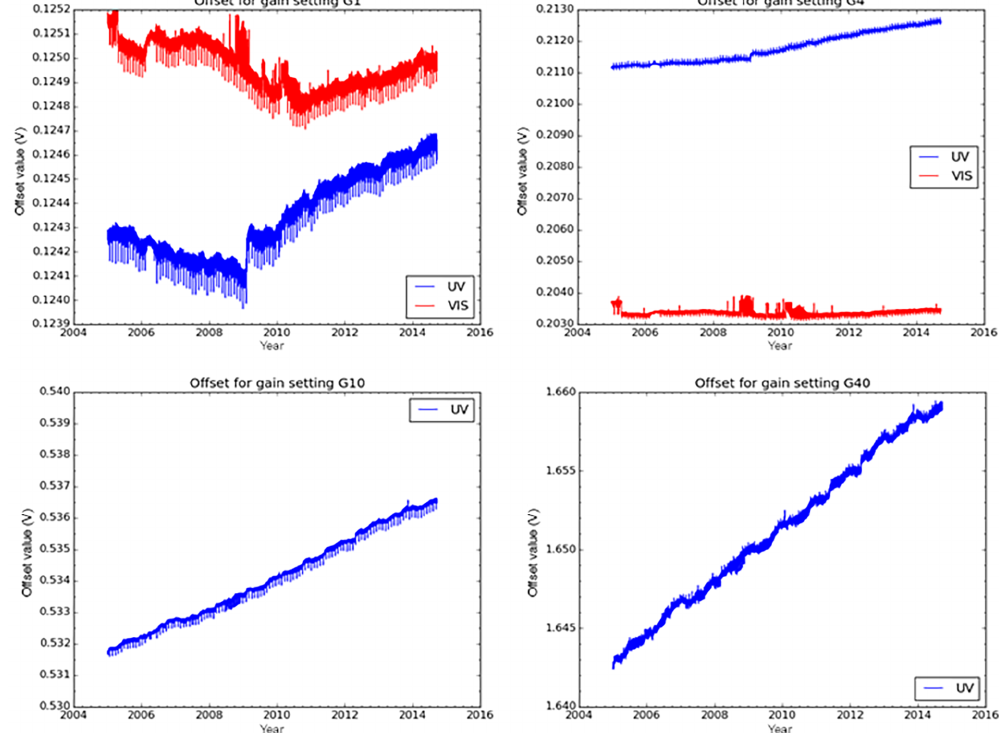
Figure 9. Changes in the electronic offset over the mission time for the four gain settings. Note that offset values for the gain setting G10 and G40 of the VIS channel are not used in radiance measurements.